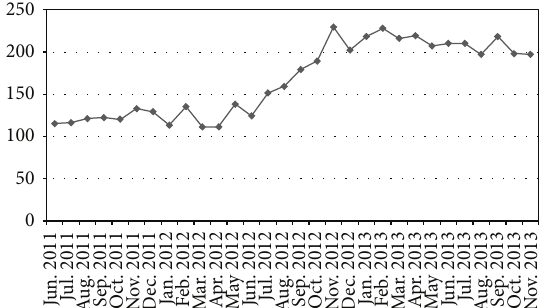
Figure 3: Average monthly outpatient turnout in the study area (Jun. 2011–Nov. 2013) (family centered approach was initiated in Jan.